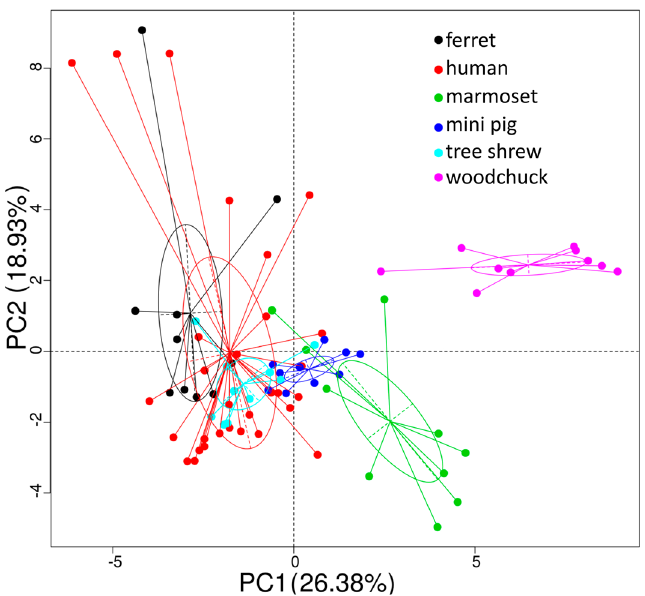
Figure 5. Principal components analysis of PICRUSt functional predictions. Functional prediction is made with PICRUSt. A principal components analysis (PCA) is used to compare of the functions of the gut microbiota, and the predicted data in level 2 of KEGG 25 are